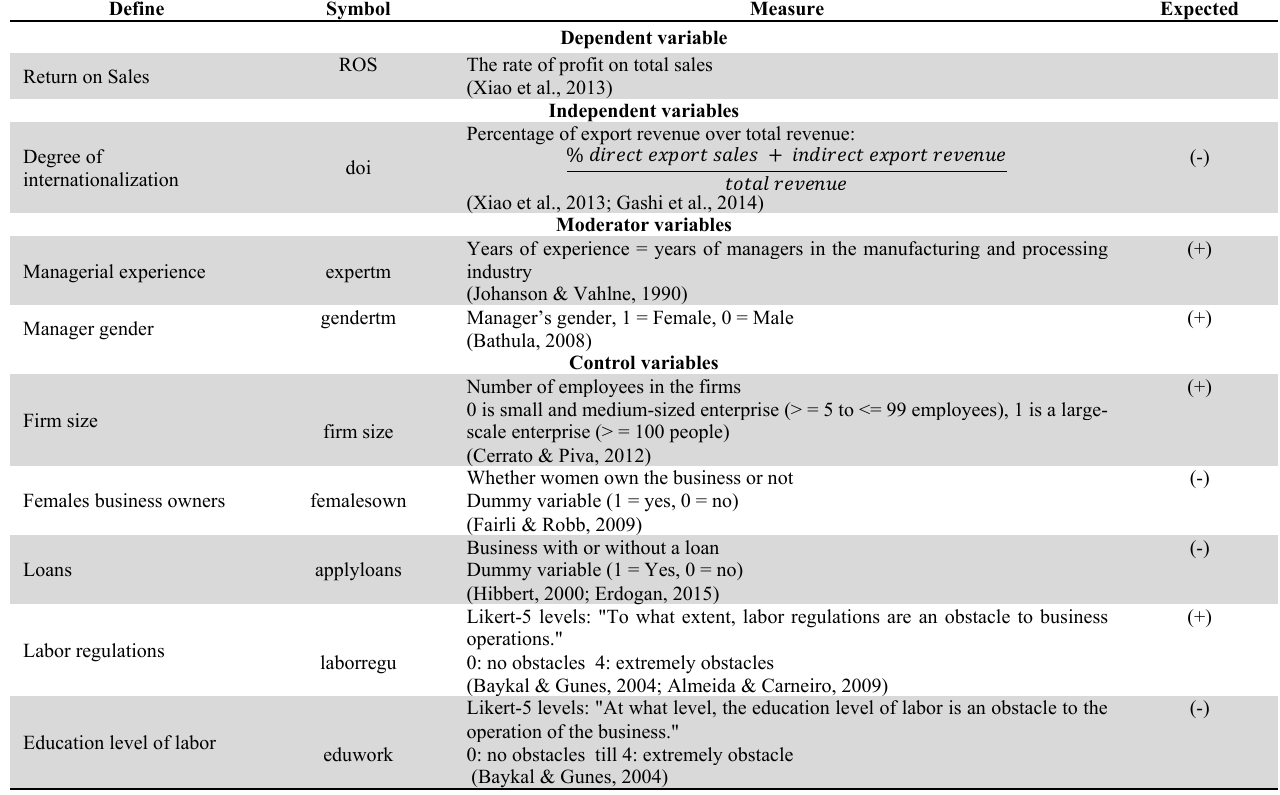
Descriptions of